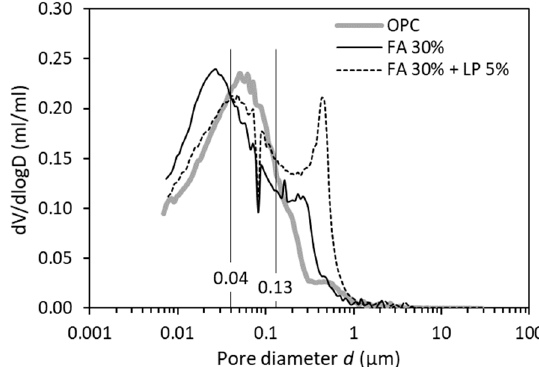
Figure 9. Differential curves of ink-bottle pore size distribution for paste specimens with different binders (w/b = 0.5, 28 days).